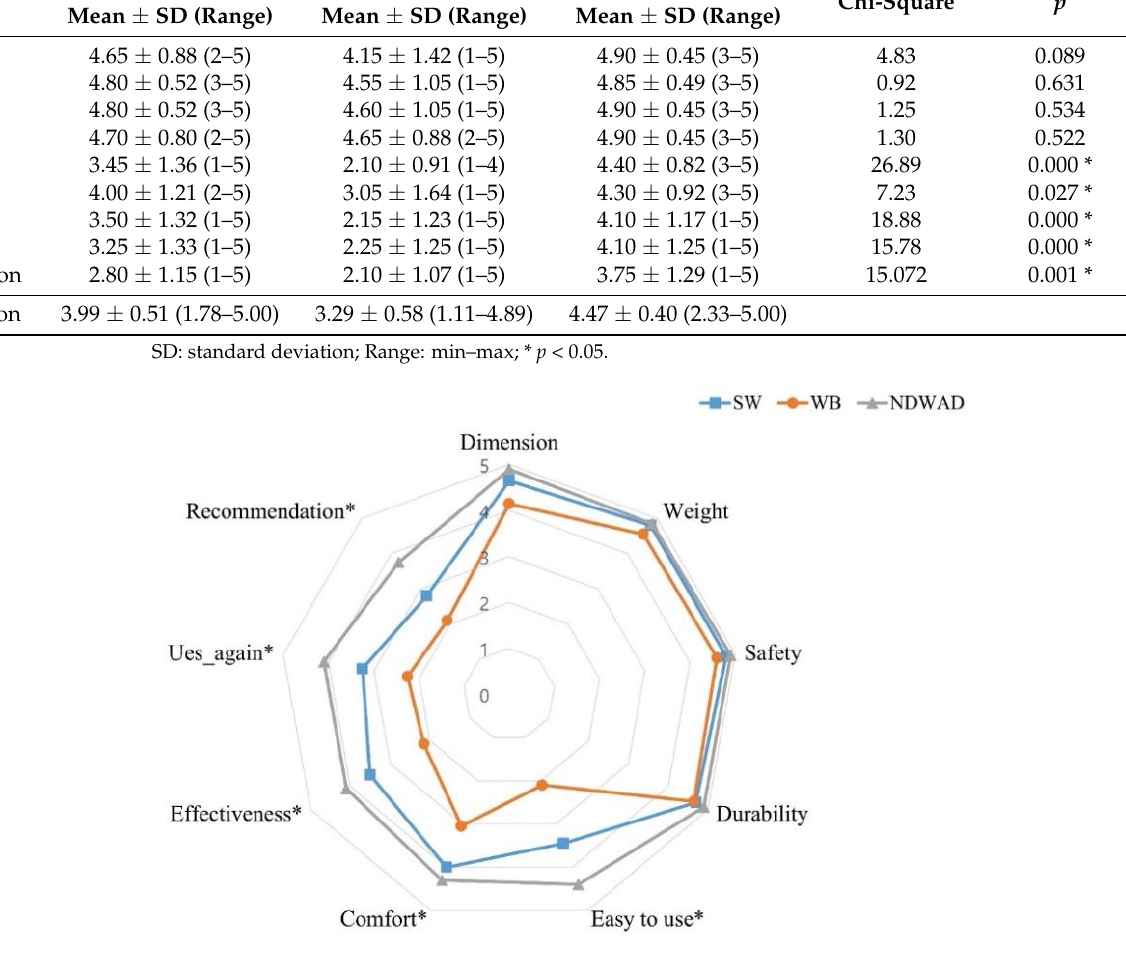
Figure 7. Satisfaction of each WAD (* p < 0.05).